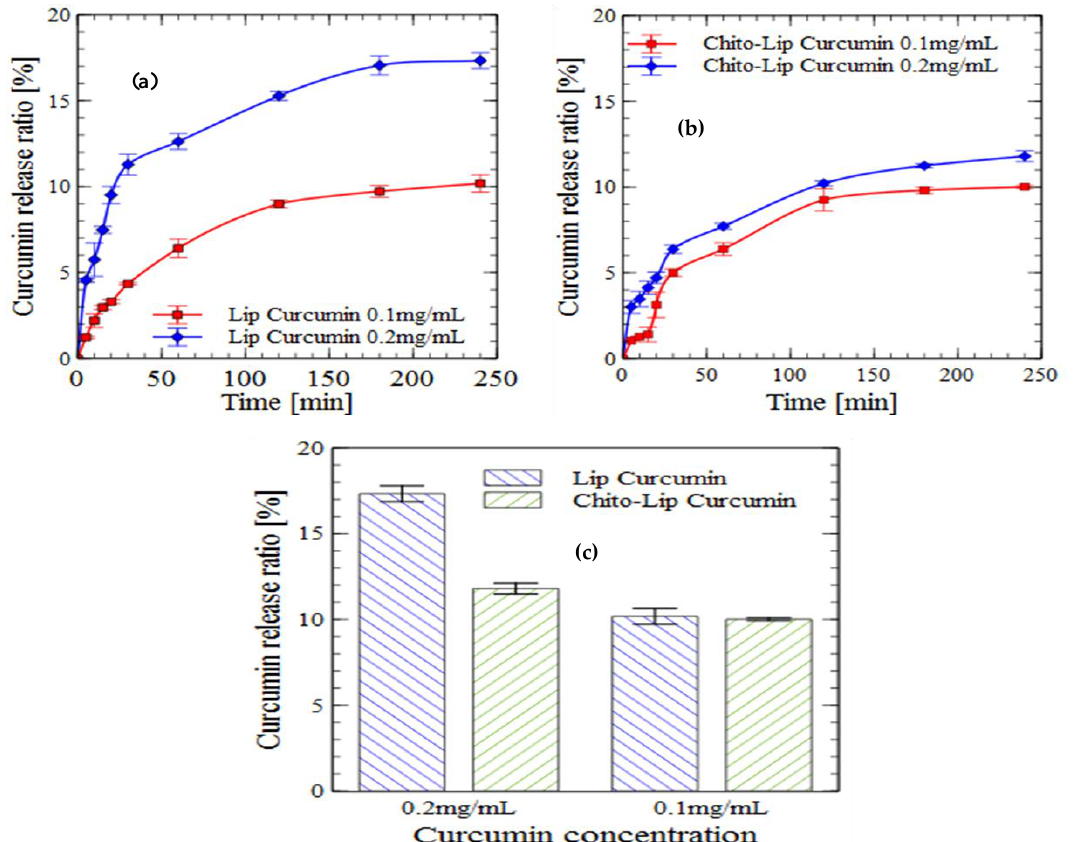
Figure 3. In vitro release (gastric digestion) of curcumin encapsulated in nanoliposomes ( a ) and chitosan-coated nanoliposomes ( b ) (values reported are mean ± SD; n = 3), and the proportions of released curcumin from nanoliposomes and chitosan-coated nanoliposomes after four hours of incubation ( c ).